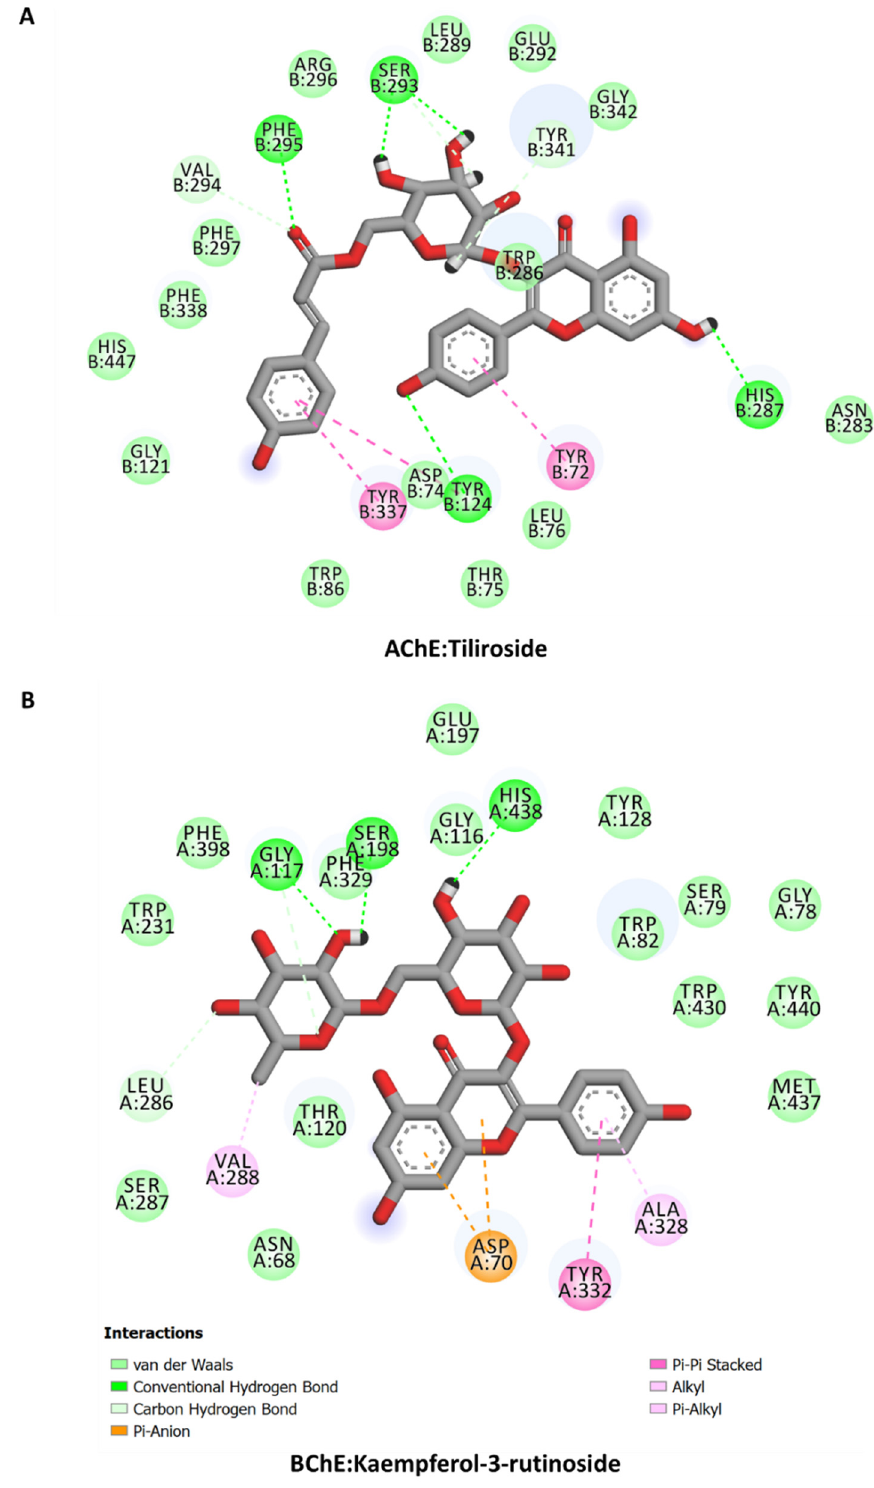
Figure 6. Protein-ligand interactions: ( A ) AChE and tiliroside, ( B ) BChE and Kaempferol-3-rutino- side.